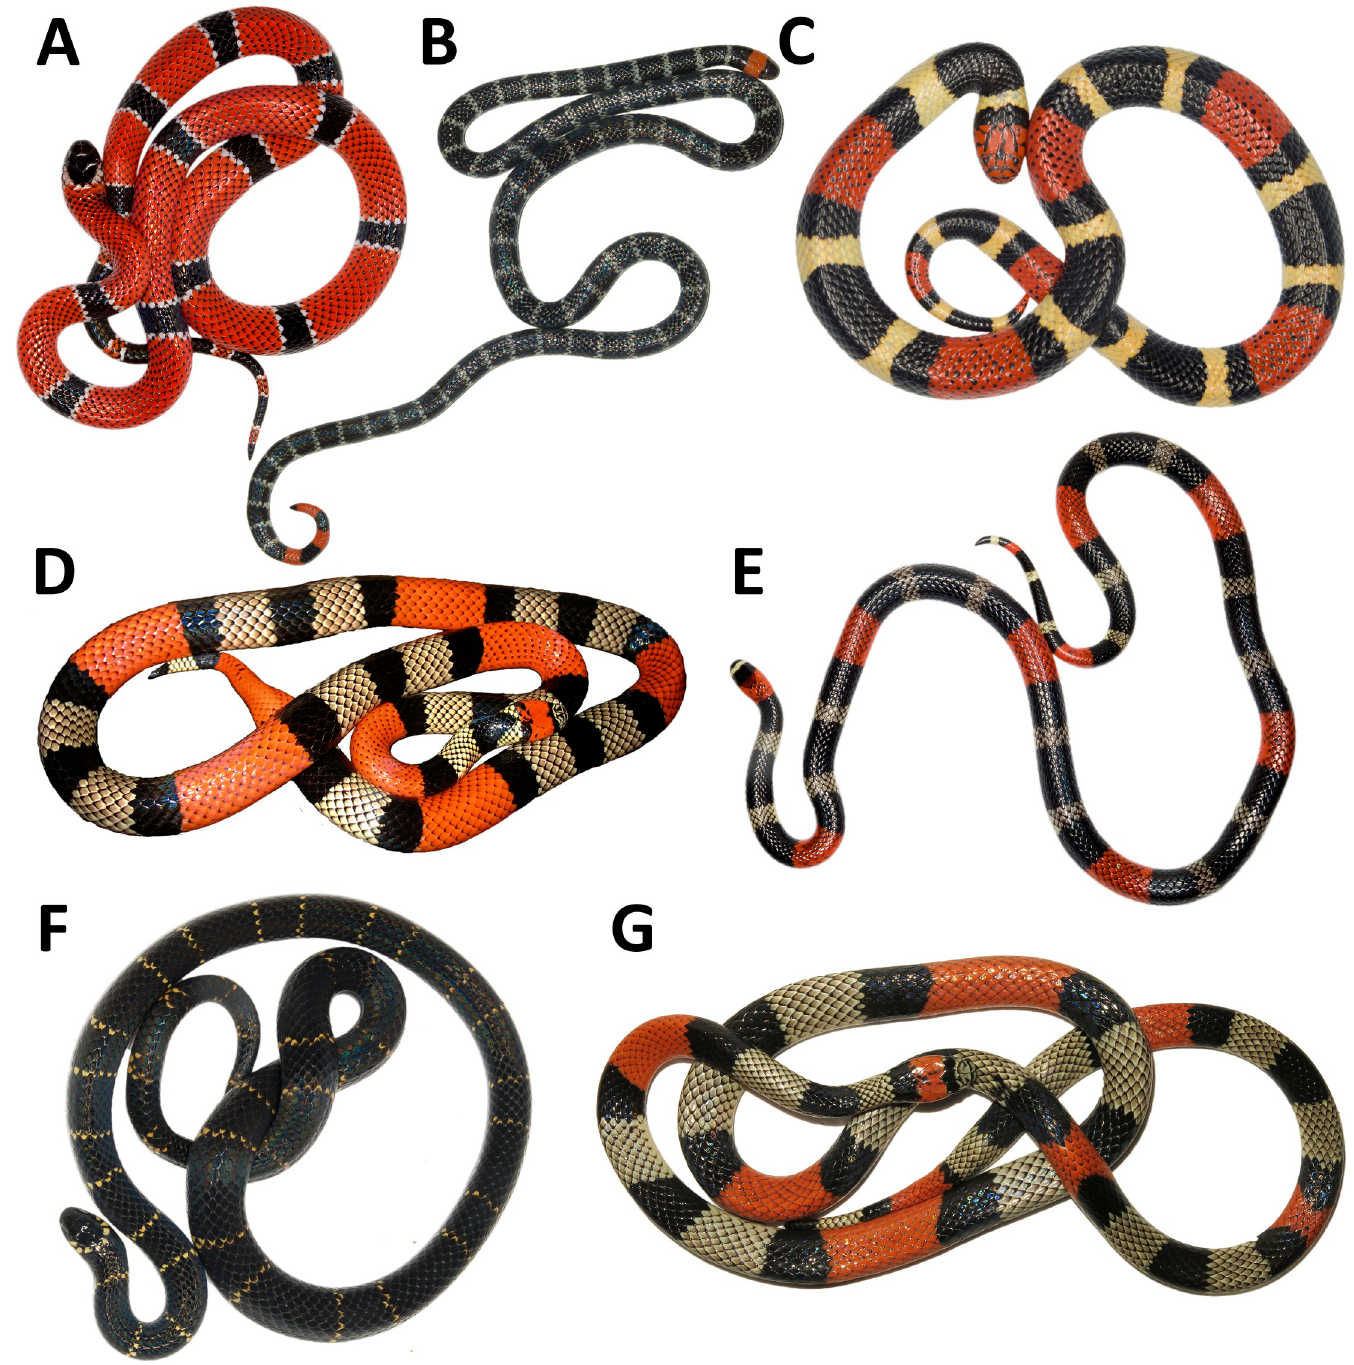
Fig 1. Photographs of Micrurus species studied herein. A. M . dumerilii ; B. M . mipartitus ; C. M . surinamensis ; D. M . isozonus ; E. M . lemniscatus ; F. M . medemi ; G. M . spixii . Photographs: A-C, E-G, JPHG; D, Jairo